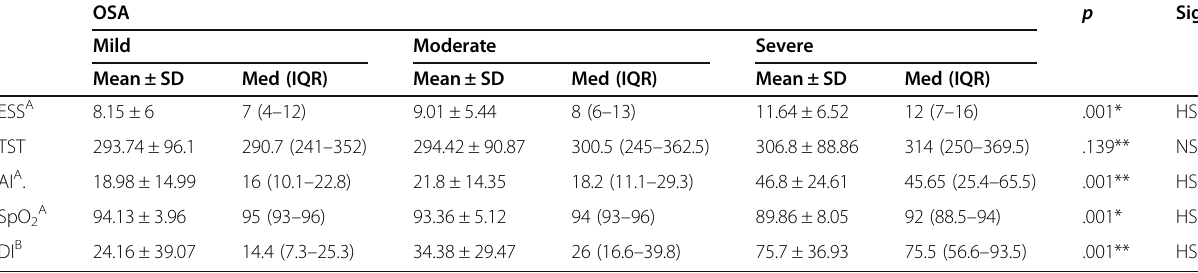
Table 4 Comparison between patients with mild, moderate and severe OSA OSA Mild Moderate